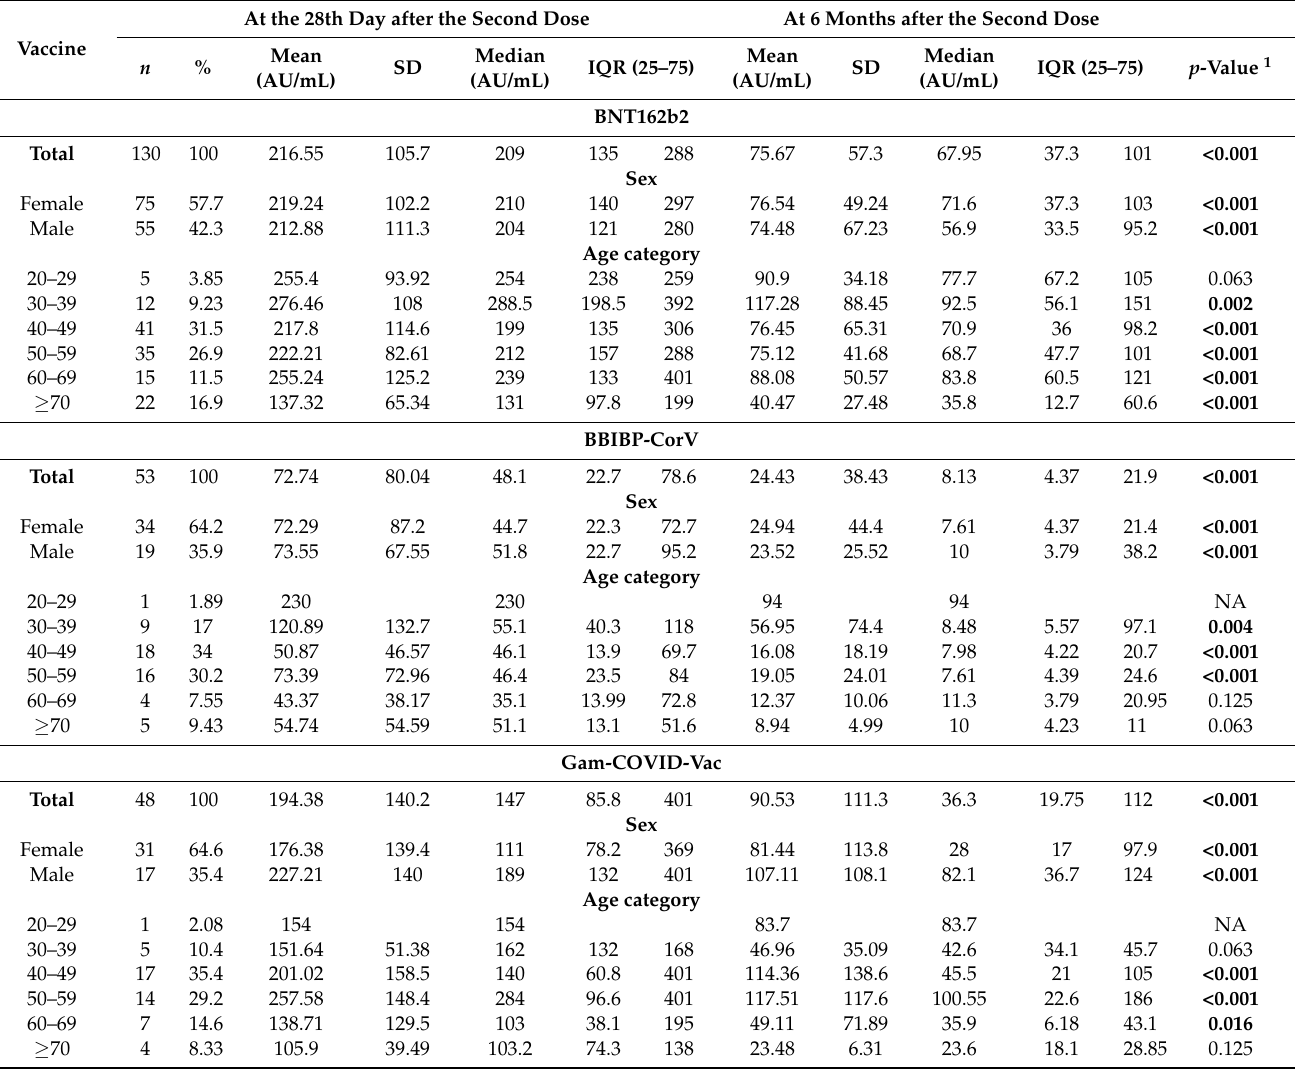
Table 1. Antibody levels on 28 days and 6 months after administration of the second dose of vaccine, stratified by sex and age groups of